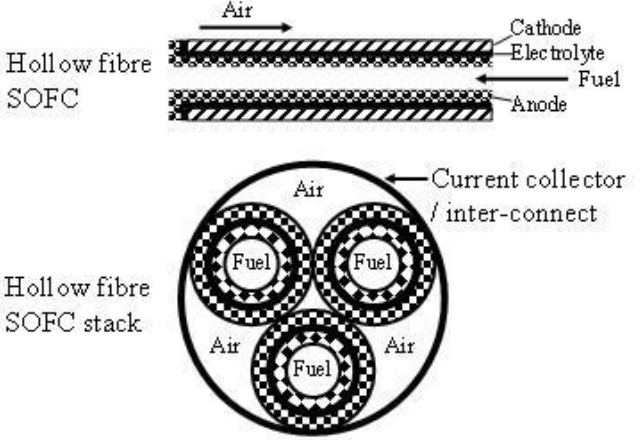
Figure 8. Hollow fiber SOFCs designed at Imperial College London (figure reprinted from Gardner et al. [47] Copyright (2000), with permission from Elsevier) [46,47,49].